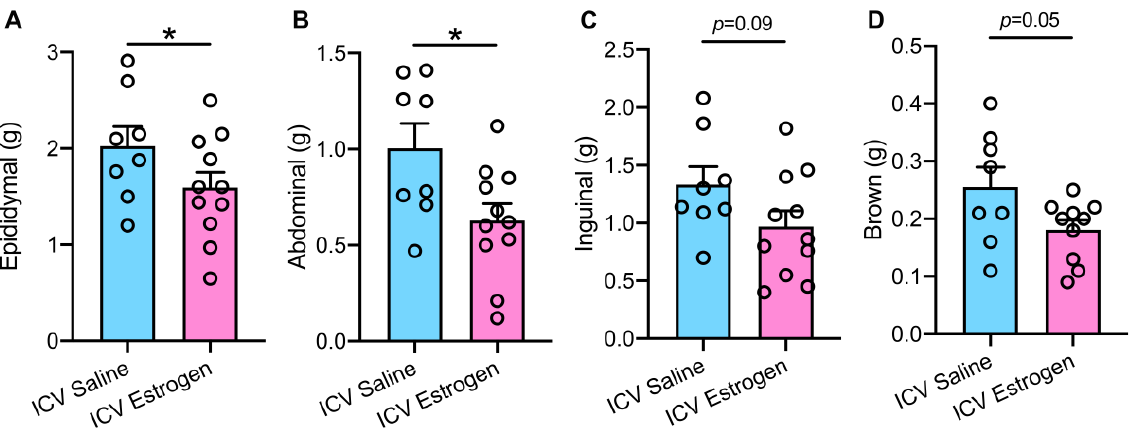
Figure 3. ICV supplementation of estrogen in males selectively reduces visceral adiposity during obesity. ( A ) Visceral epididymal, ( B ) visceral abdominal, ( C ) subcutaneous inguinal, and ( D ) thermogenic brown adipose mass following 6-day administration of ICV 17- β -estradiol or saline control in obese male mice. n = 8 – 11. * p < 0.05 vs. ICV Saline.